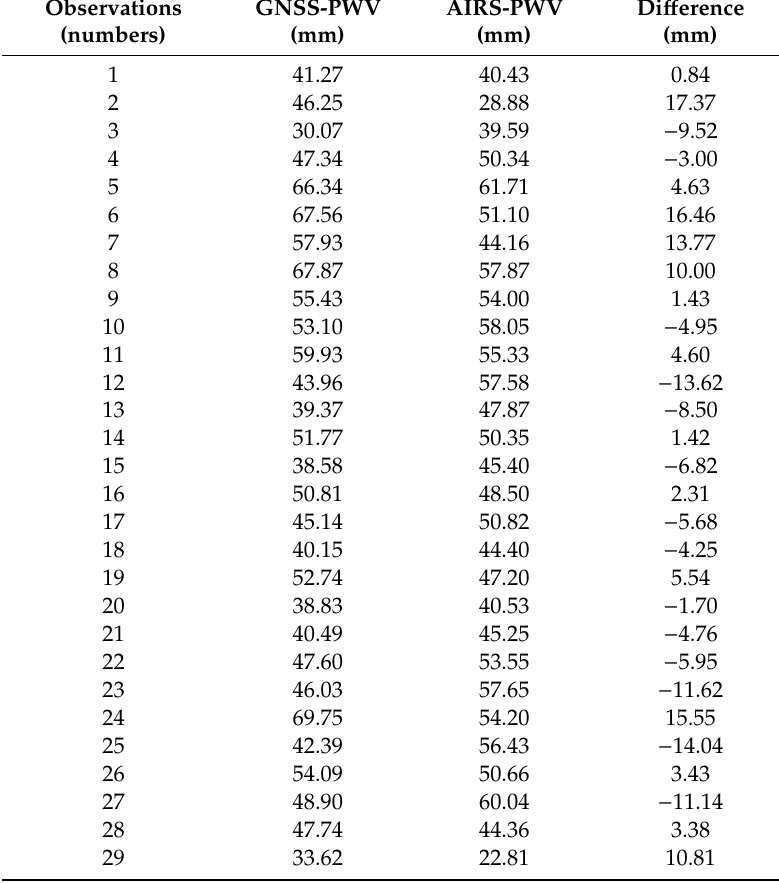
Figure 9. Comparison of shipborne GNSS-PWV against AIRS-PWV. The slope of linear fitted trend the correlation coefficient between GNSS-PWV and AIRS-PWV is calculated with a linear regression model. Table 5. Comparisons between GNSS-PWV and AIRS-PWV for a period from DOY 242 to DOY 264, 2018 in the Pacific Ocean.